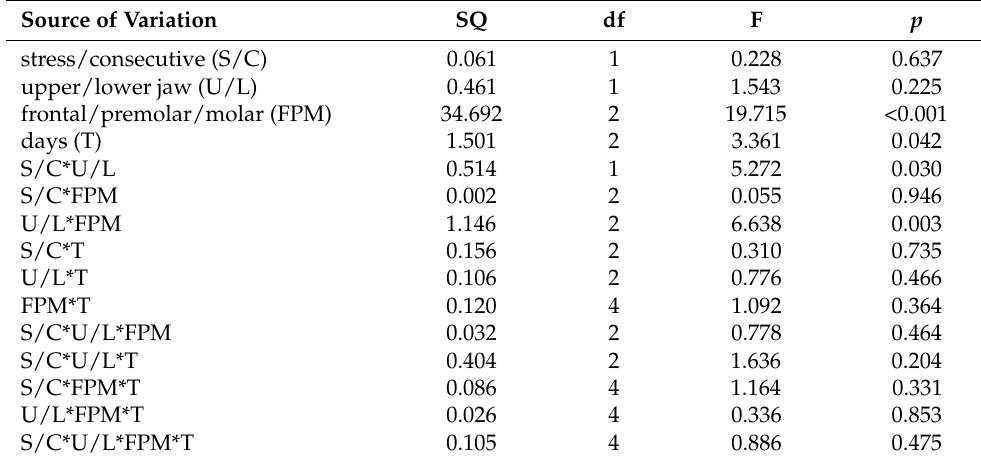
SQ, sum of squares; df, degrees of freedom.